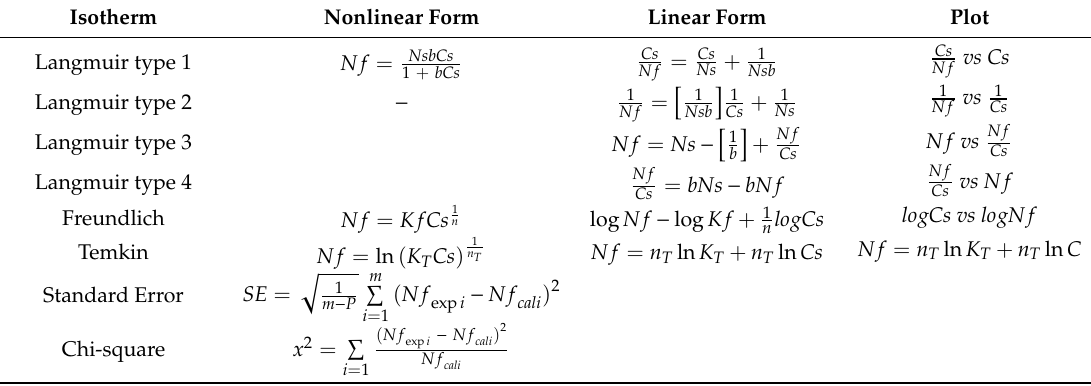
Table 5. Sorption isotherm models, the linear and nonlinear representations, and respective plot graphical